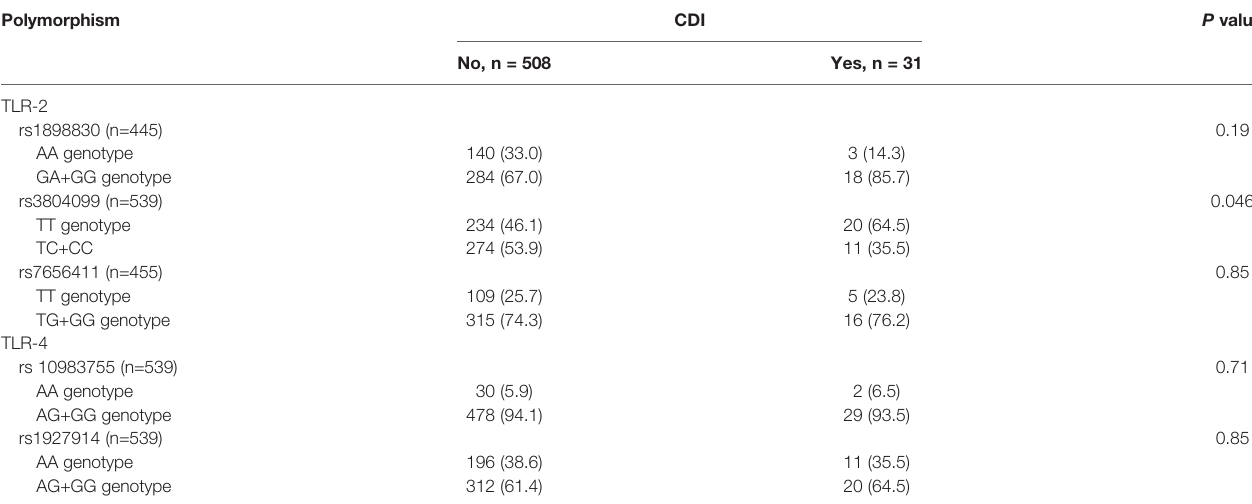
TABLE 1 | Correlation of TLR-2 or TLR-4 polymorphisms and the development of Clostridioides dif fi cile infection (CDI) in 539 patients. Polymorphism